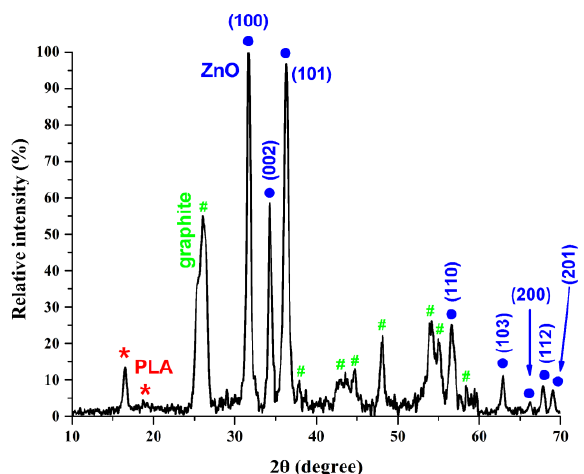
Figure 2. A typical XRD pattern of ZnO / 3D-printed graphene samples. The XRD peaks of the graphite, PLA and ZnO are indicated with green hashes, red asterisks and blue dots, respectively.